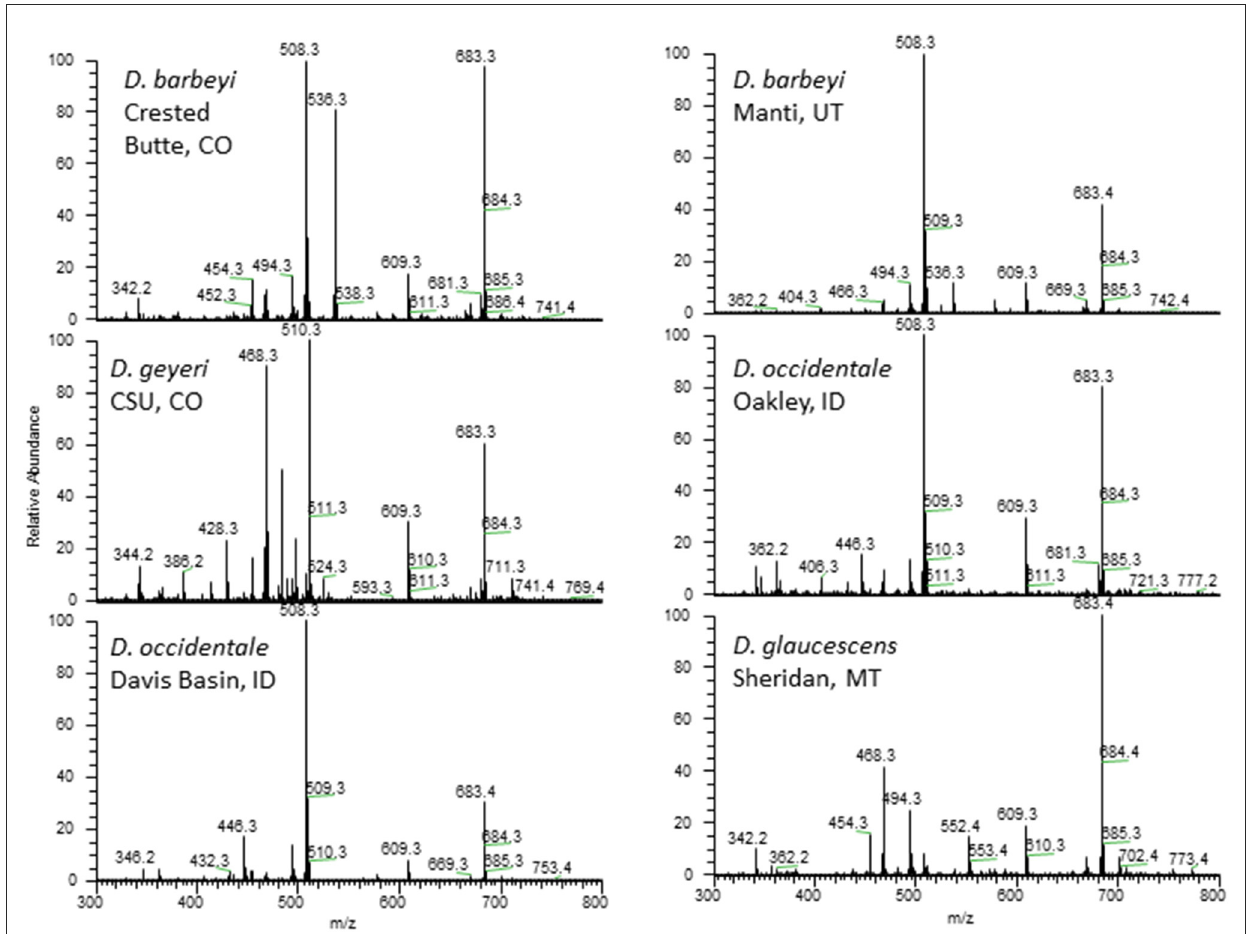
FIGURE1 Electrospray mass spectra of 6 collections of Delphinium . Peaks of note include deltaline (MH + = 508), methyllycaconitine (MH + = 683), 14-acetylbrowniine (MH + = 510), and 14-acetyldictyocarpine (MH + = 536)